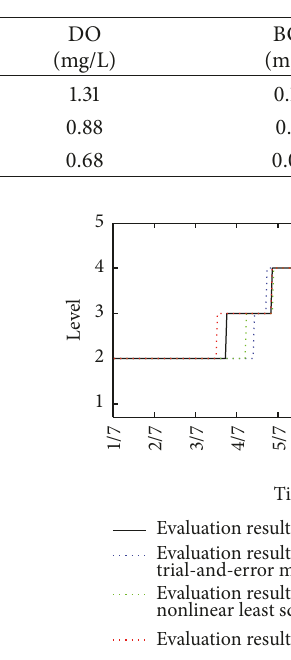
Table 6: RMSE values of each water quality index obtained by different methods.